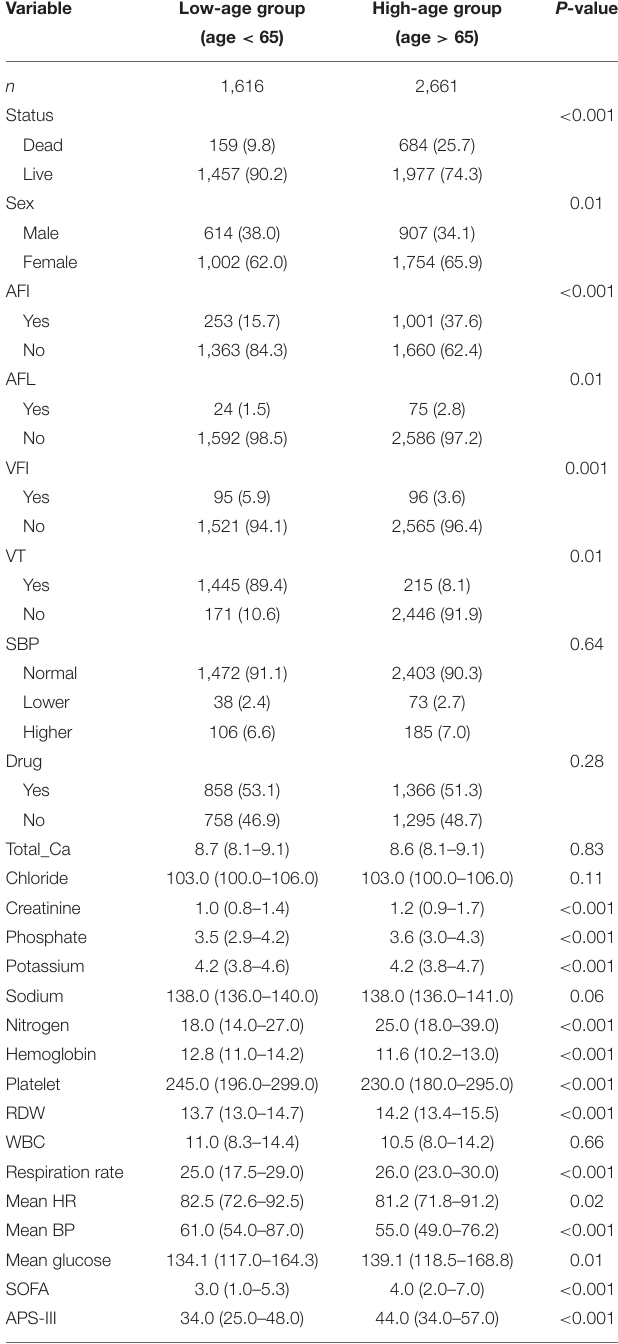
TABLE 4 | Baseline characteristics between different age